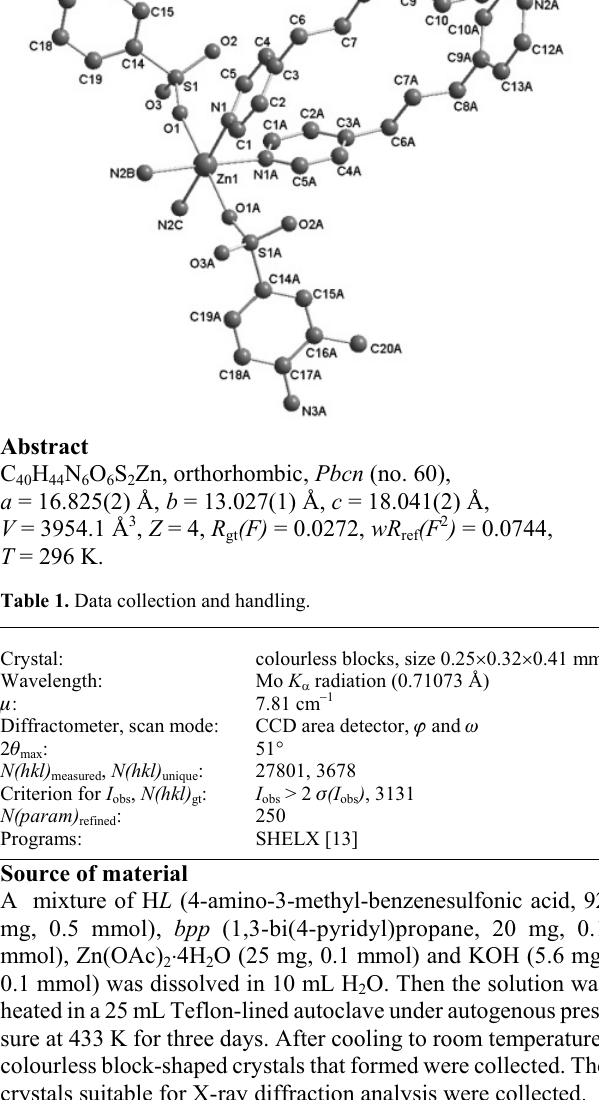
Table 2. Atomic coordinates and displacement parameters (in Å 2 )